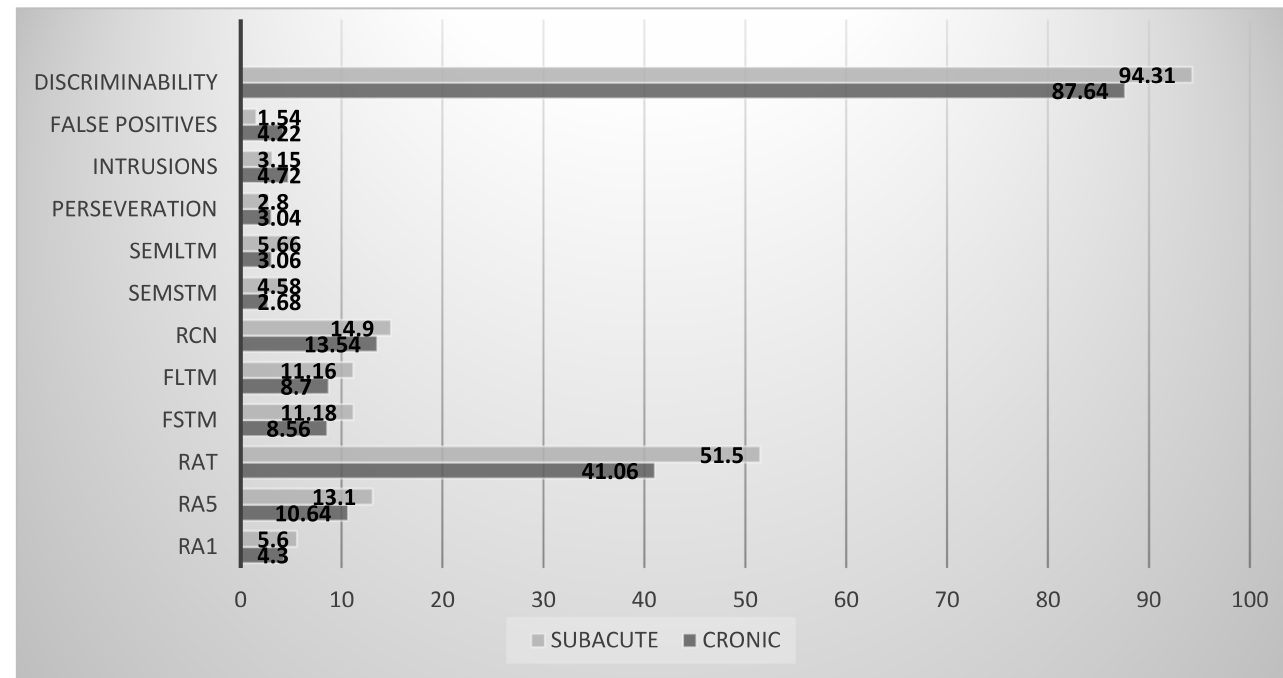
Figure 3. Test de aprendizaje verbal España–Complutense (TAVEC) scores in SCI patients. Legend: RA 1 : hits in test 1 of the A list; RA 5 : hits in test 5 of the A list; RA T : sum of the hits in the five trials; FSTM: free short-term memory; FLTM: free long-term memory; RCN: recognition; SemSTM: semantic short-term memory; SemLTM: semantic long-term memory; FP: false